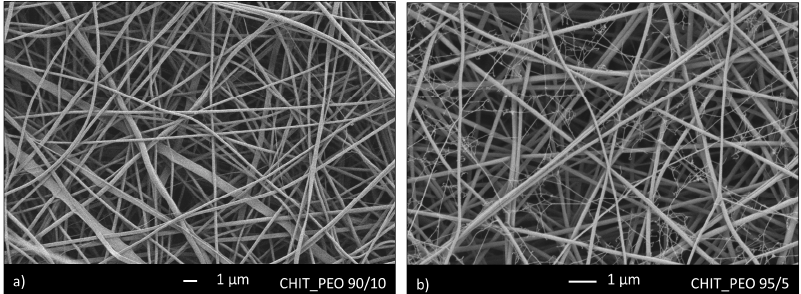
Figure 1. SEM analysis of CHIT_PEO fibers with ratio 90/10 ( a ) and 95/5 ( b ).